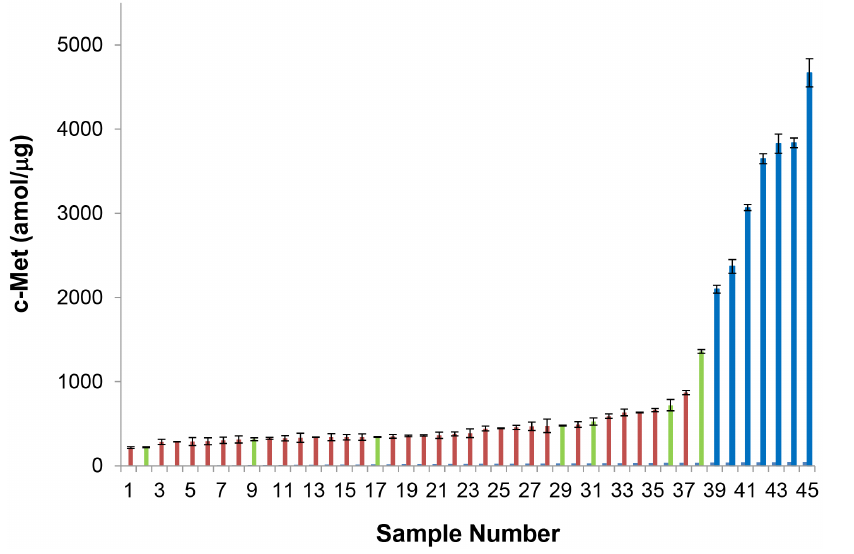
Figure 6. Absolute levels of Met in those GEC tumors above the LOD (45/130) as measured using Liquid Tissue-SRM. Blue indicates MET gene amplified samples (ratio of MET/CEP7 $ 2) as determined by FISH, and green indicates those not gene amplified (ratio , 2). Samples in red were not FISH tested. Sample 36 (526.93 amol/ug) is taken from reference 18 (sample obtained at disease recurrence after initial onartuzumab